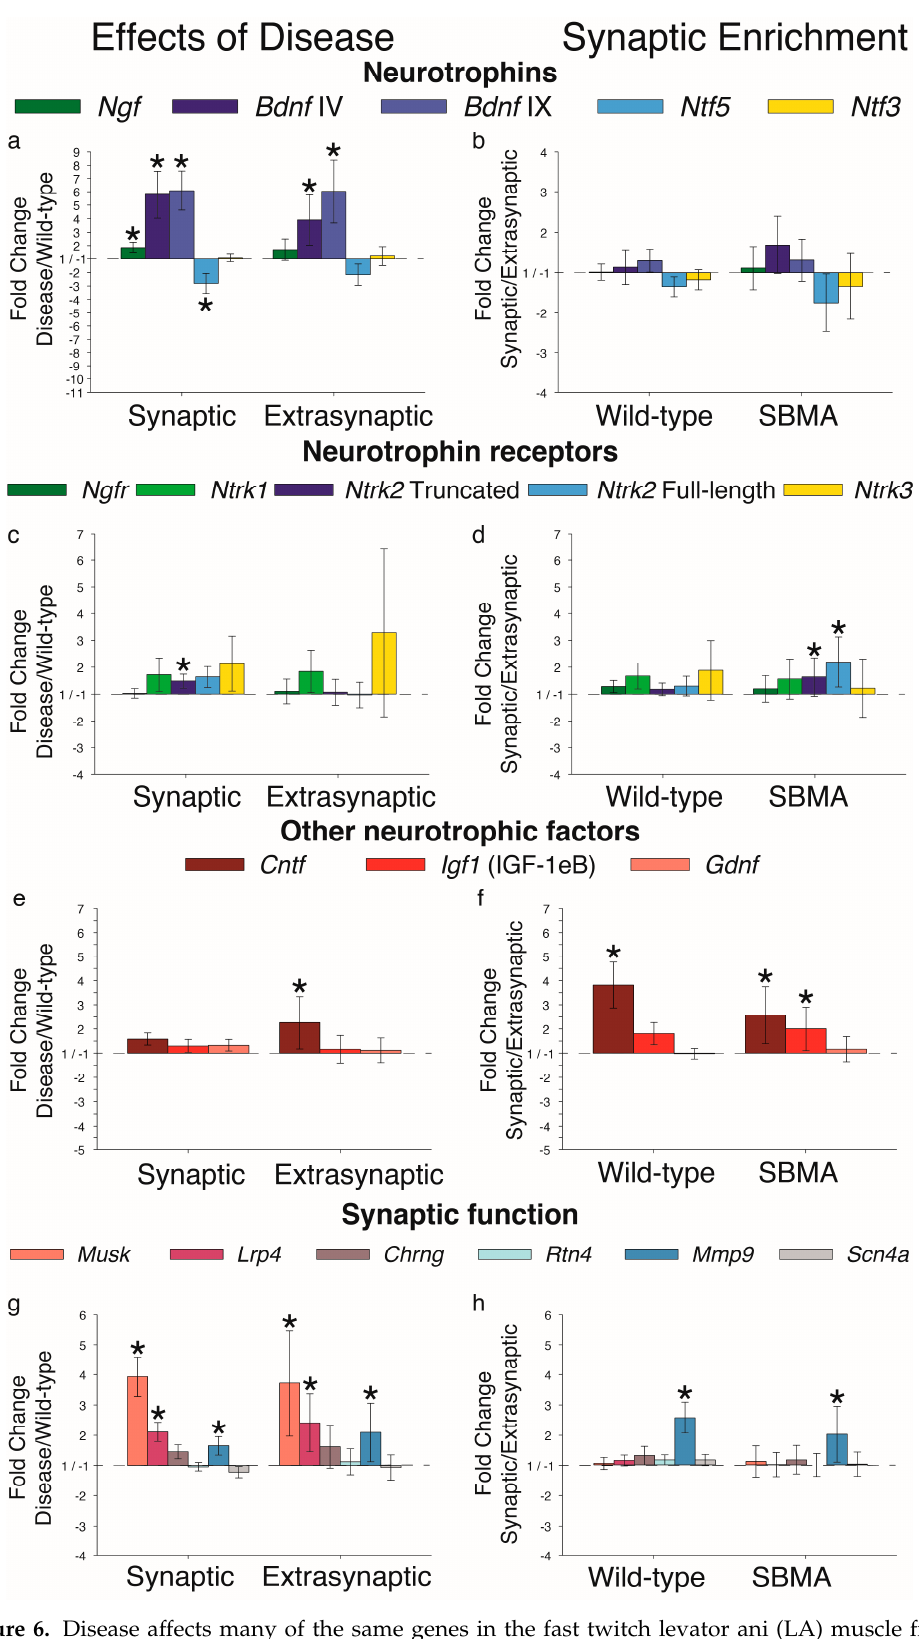
Figure 6. Disease affects many of the same genes in the fast twitch levator ani (LA) muscle from knock-in (KI) mice. ( a ) Neurotrophin ( Ngf , Bdnf , and Ntf5 ) expression was disrupted by disease, largely comparable to what was seen for the fast twitch EDL of diseased 97Q and myogenic males. One notable difference was an upregulation of Bdnf induced by disease rather than the expected